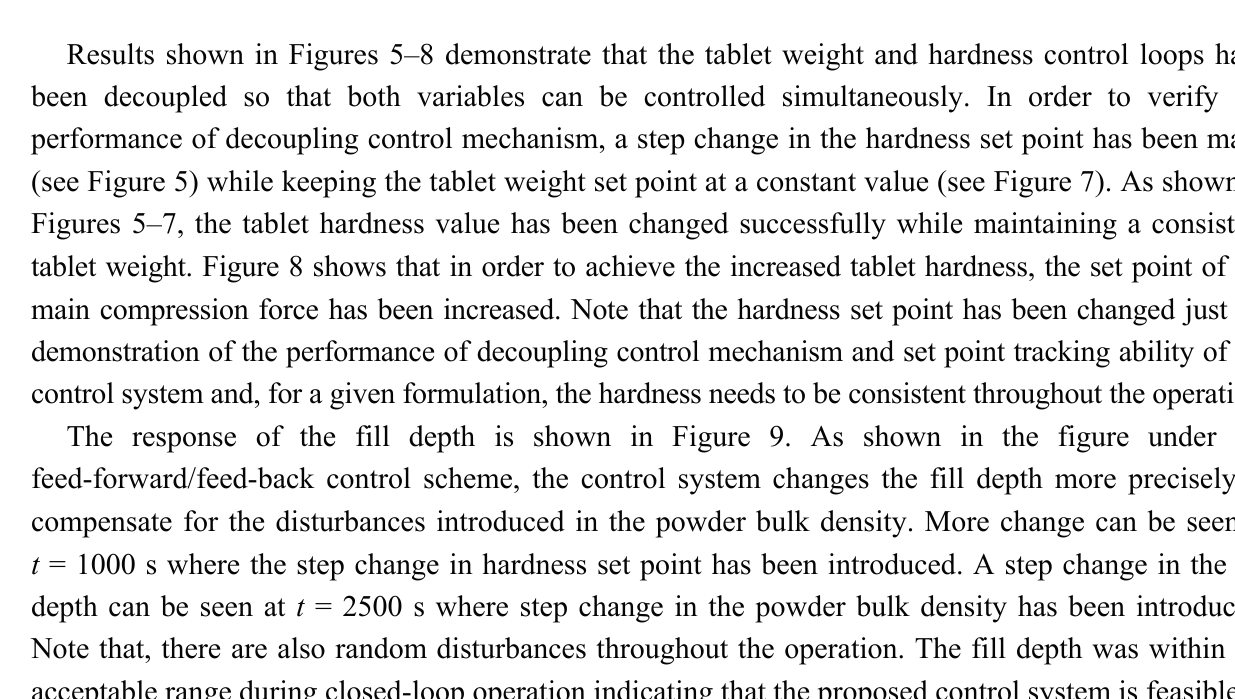
Figure 8. Closed-loop response of main compression force (performance of slave